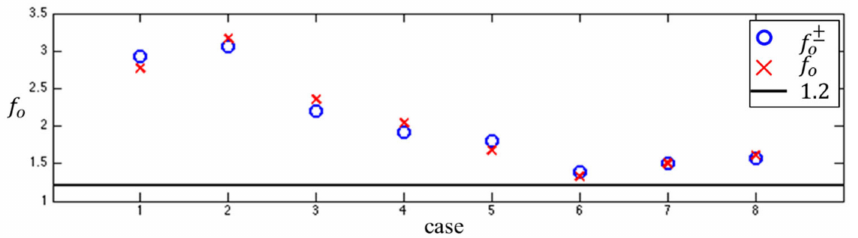
Figure 11. Comparisons of the safety factors against overturning among the minimum of f o ± (o), f o ( × ) and safety criteria